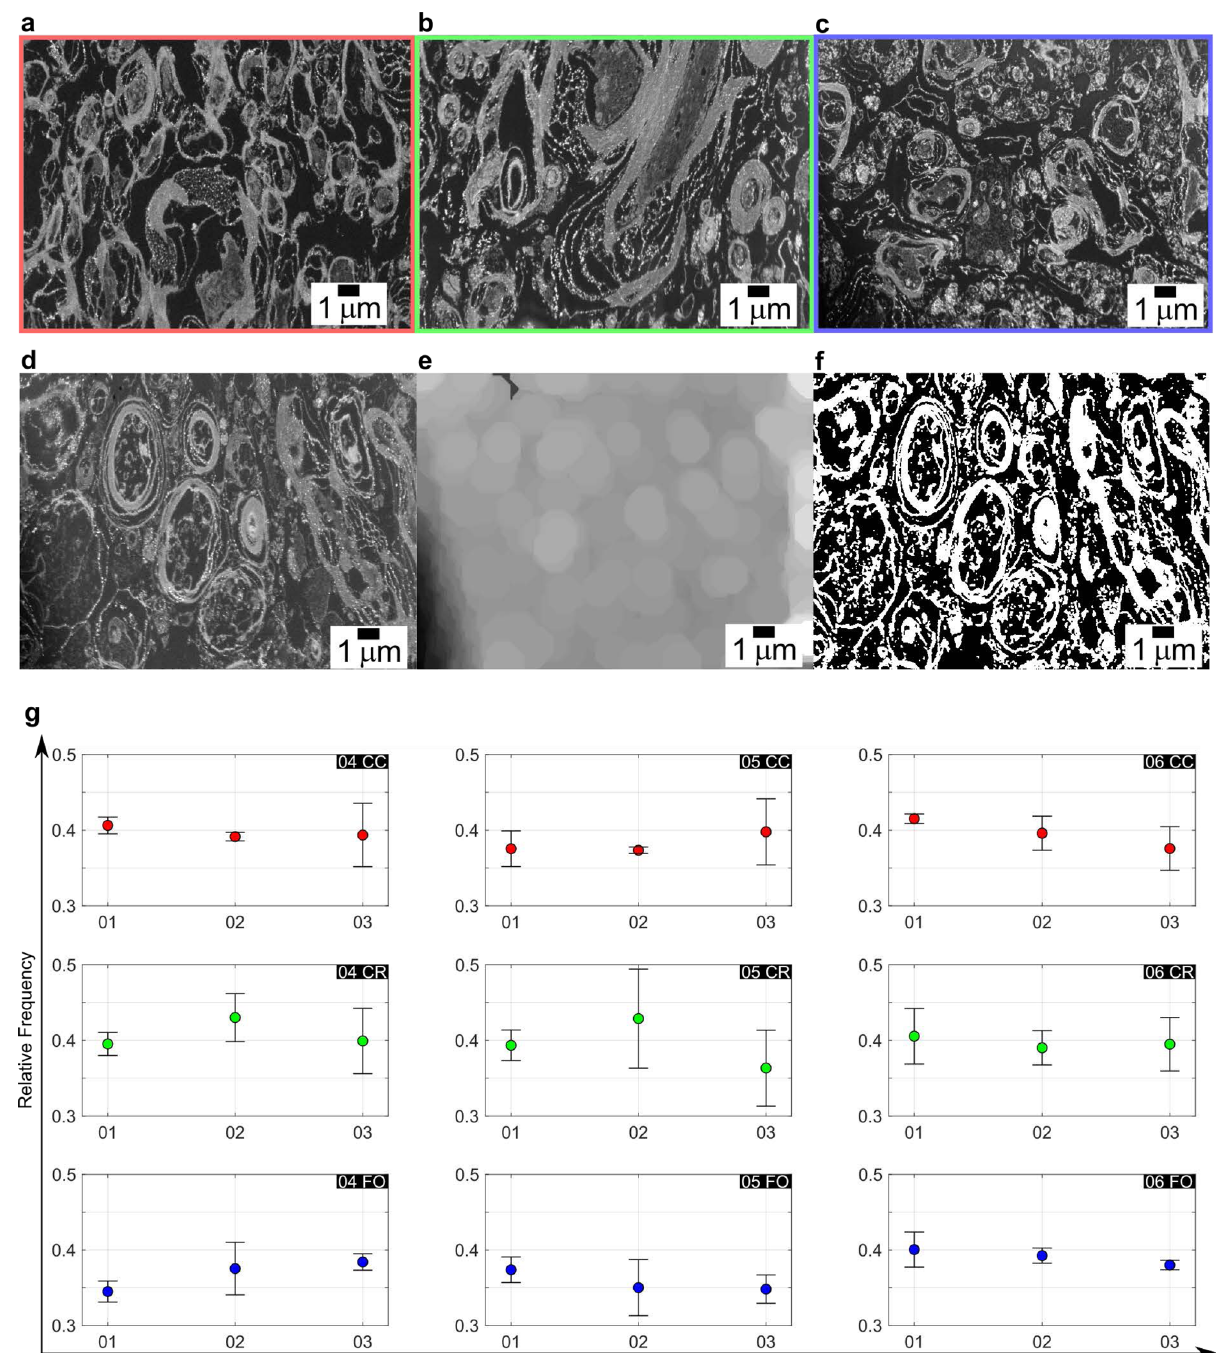
Fig. 3 FIB-SEM acquisitions, processed slices and results. a – c The three areas, CC in red ( a ), CR in green ( b ) and FO in blue ( c ), do not appear at fi rst signi fi cantly different in the 2D images. d – f A series of post processing procedures is applied to reduce the noise in the background before the fi nal binarisation operation. The input image ( d ) is fi ltered and cleaned of the noise, its own background ( e ) is subtracted to it and fi nal binarisation follows ( f ). By binarising the 2D images a quanti fi cation of white pixels representing the myelin is performed. g The relative frequency of white pixels was calculated in each of the six 2D SEM images from each sample of each subject. The results show a standard deviation from the average values that differ slightly between samples, but recorded values tend to cluster around a relative frequency value of 0.4. This hints at a constant myelination level that is maintained throughout the areas, with the exception of FO showing a slightly lower average frequency when compared to CC and